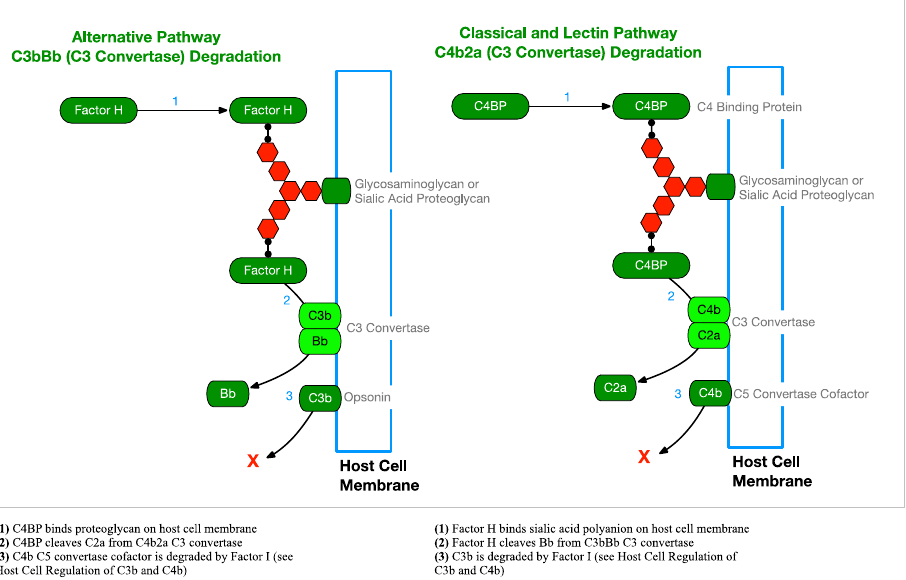
Figure 9. Host Cell C3 Convertase Regulation—Mammalian host cells must be able to degrade the C3 convertases of all three complement pathways to prevent host cell opsonization from potentially leading to phagocytosis [37] .